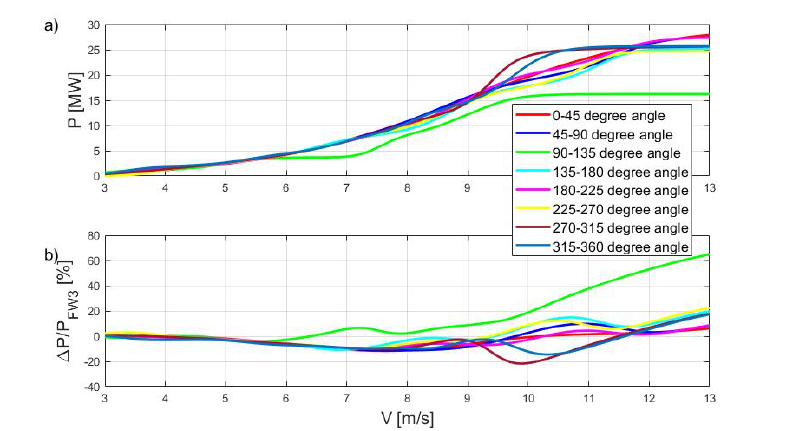
Figure 13. Wind power plant FW3: ( a ) FW3 power characteristic for wind directions in ranges of 45 degrees, ( b ) generated power difference for selected wind directions as percent of the farm’s rated